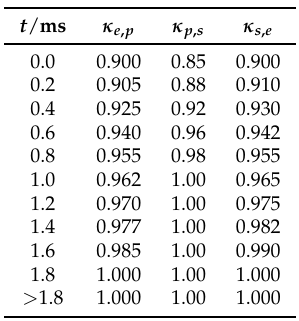
Table A7. Values of numerical parameter κ in Simulation